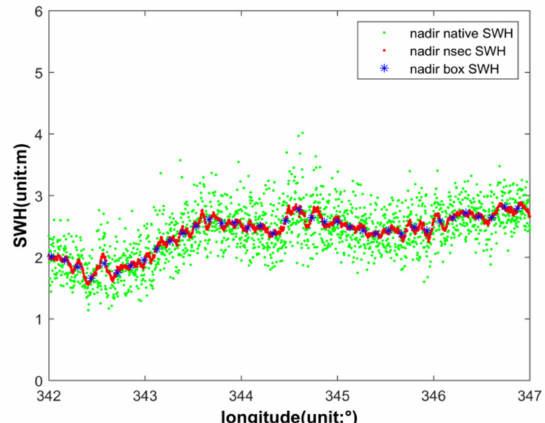
Figure 1. Comparison of three kinds of nadir Significant Wave Height (SWH)